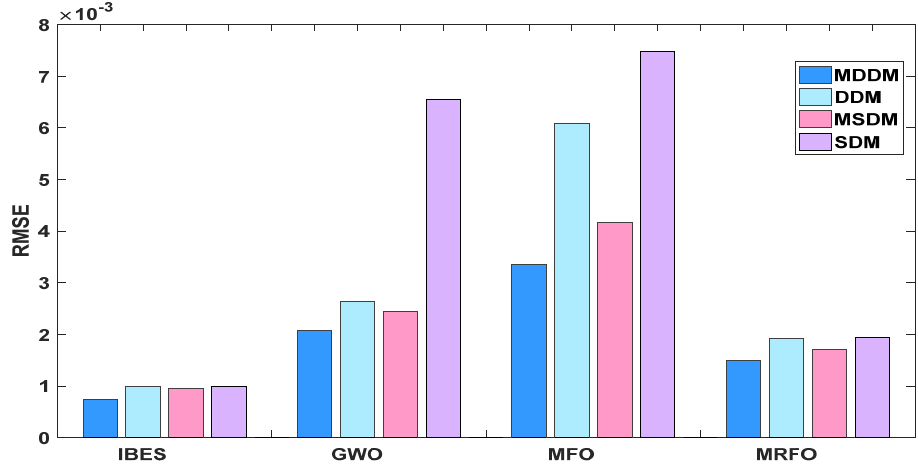
Table 8. Estimated parameters and RMSE values of the IBES, GWO, MFO, and MRFO applied to the MDDM, DDM, MSDM, and SDM.